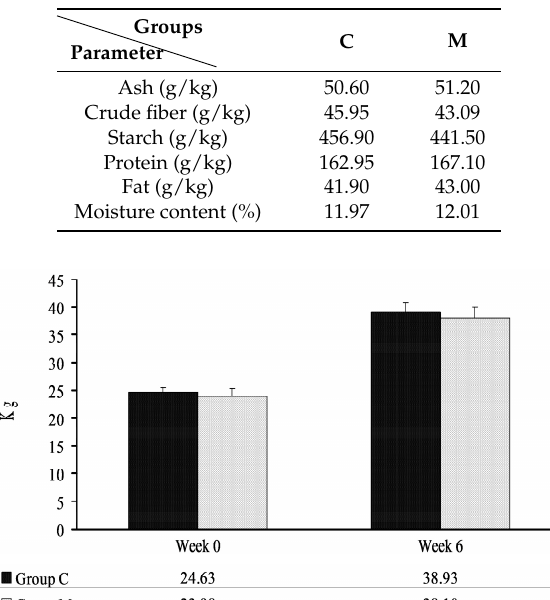
Table 2. White blood cell counts, platelet counts, and mean platelet volume in the peripheral blood of pigs from groups C and M.